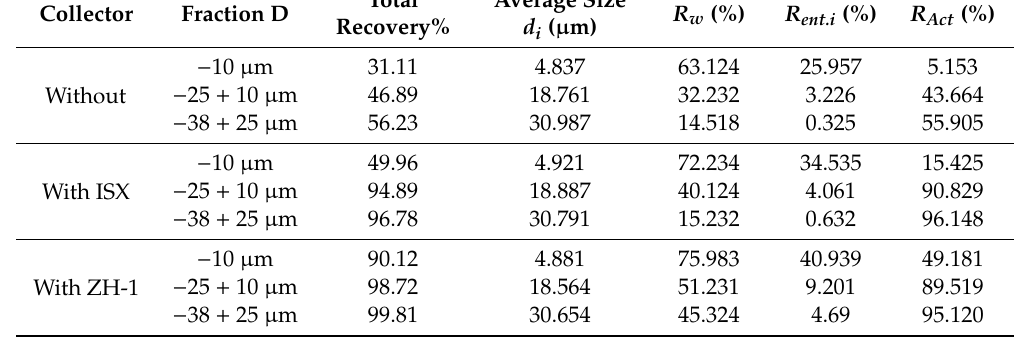
Table 3. The entrainment recovery of the three size fractions in the presence and absence of collector.